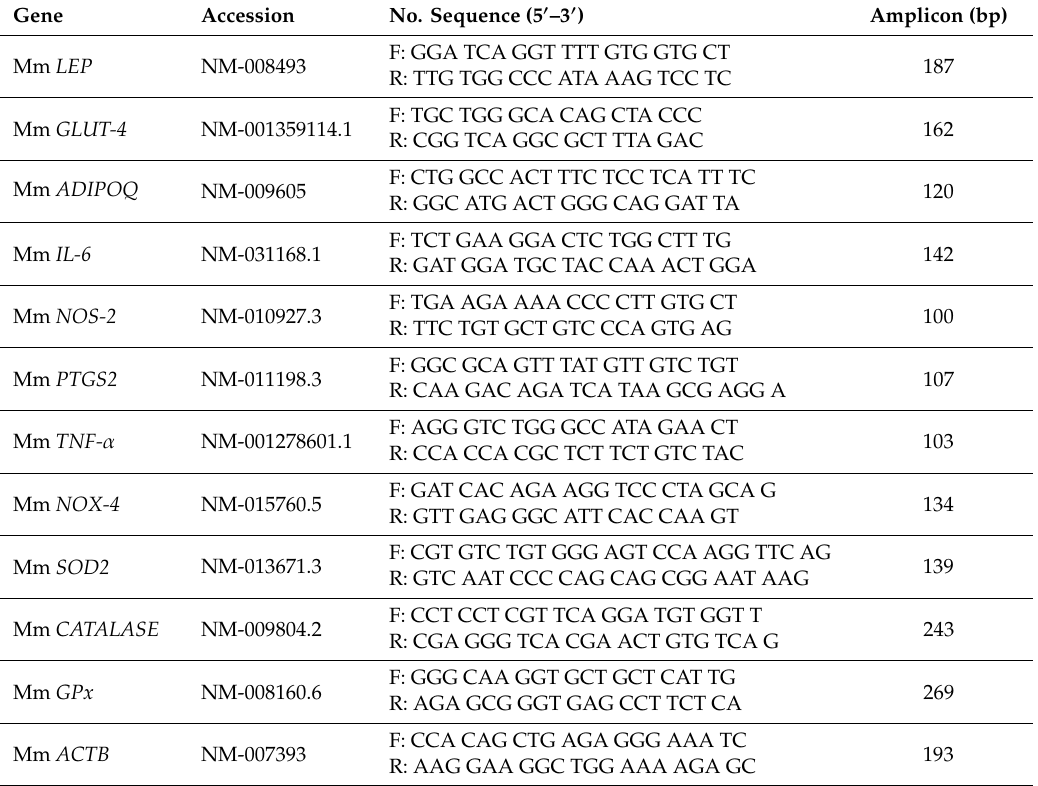
Table 1. The primers sequence used for real-time